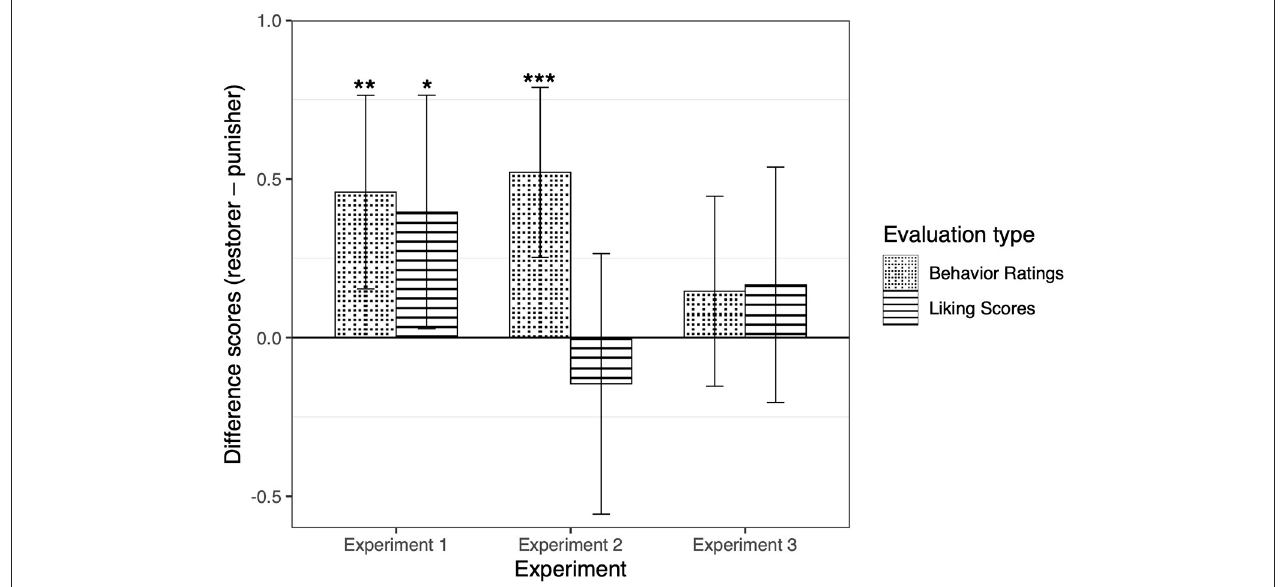
FIGURE 2 | Differences of behavior ratings and liking scores between the restorer and the punisher (restorer—punisher) in Experiment 1, 2, and 3. In Experiment 1, differences of behavior ratings and liking scores were both significant, showing that children approved of the restoration behavior; in Experiment 2, only the differences of behavior ratings were significant; in Experiment 3, neither differences of behavior ratings nor liking scores was significant. The error bars represent the 95% CI. *** p < 0.001, ** p < 0.01, * p < 0.05.